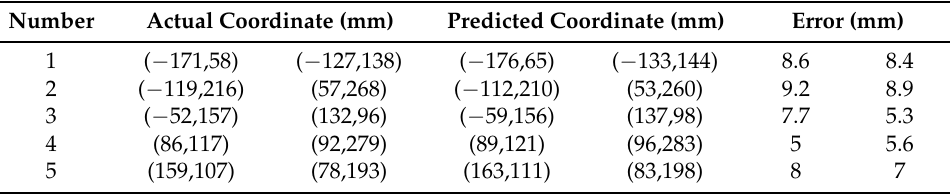
Table 2. Experimental